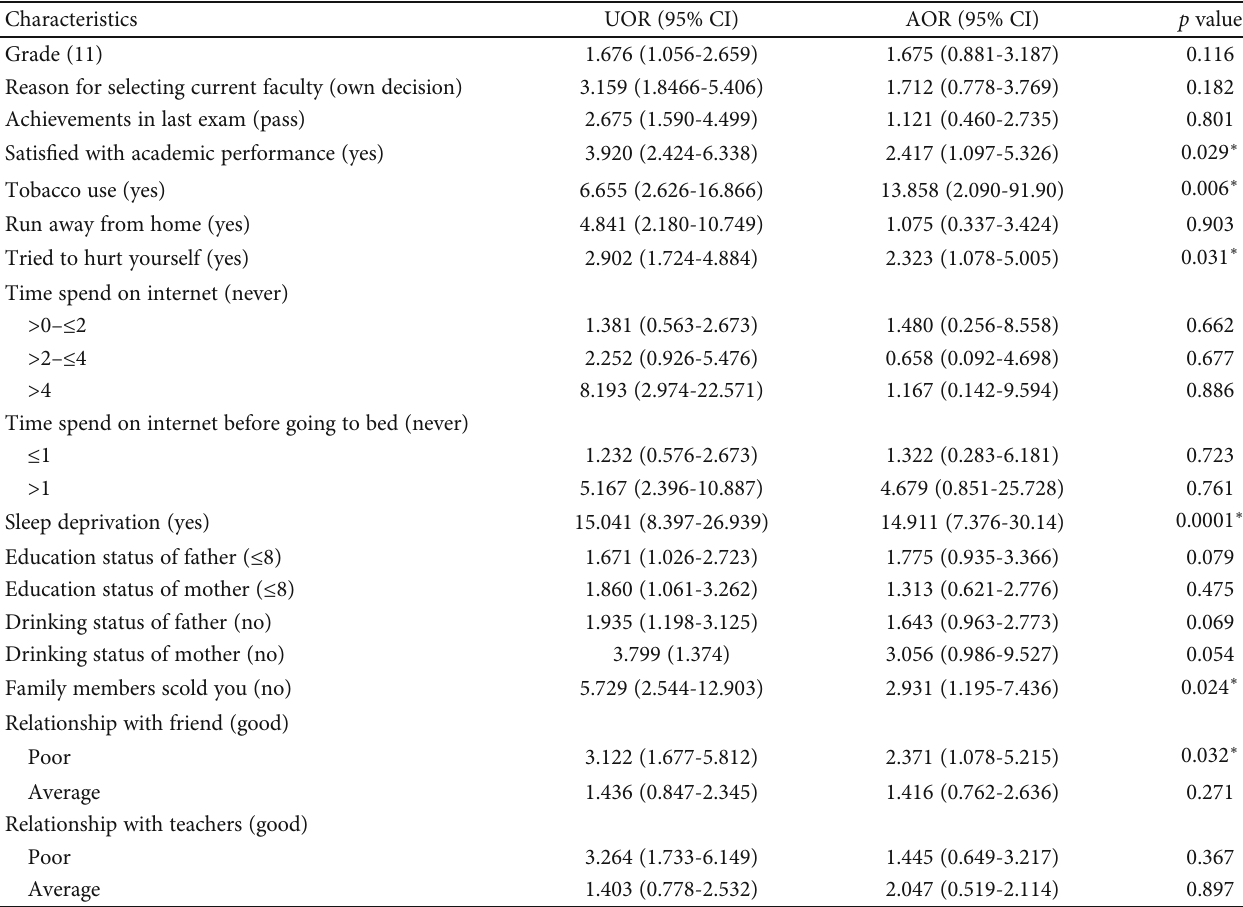
Table 7: Multivariable linear regression of factors associated with